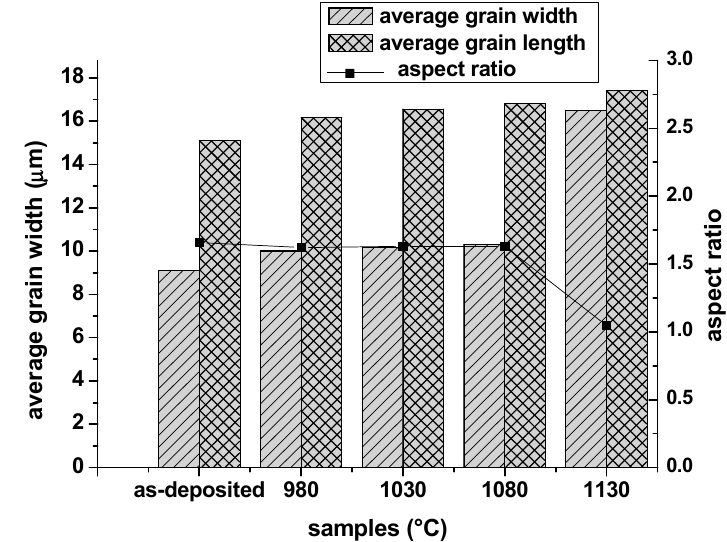
Figure 5. Average grain width, average grain length and grain width–length ratio of samples in di ff erent solution heat treatment different solution heat treatment conditions.